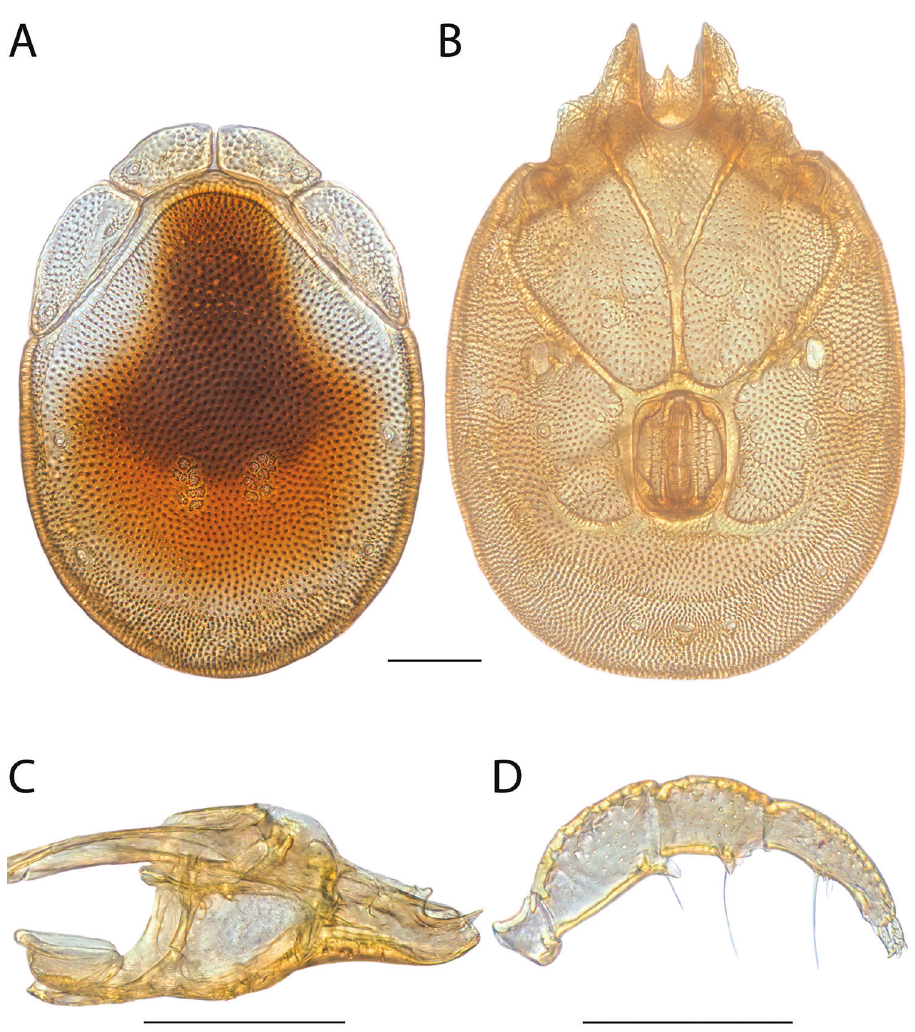
Figure 266. Torrenticola unimaculata sp. n. male: A dorsal plates B venter (legs removed) C subcapitulum D pedipalp (setae not accurately depicted). Scale = 100